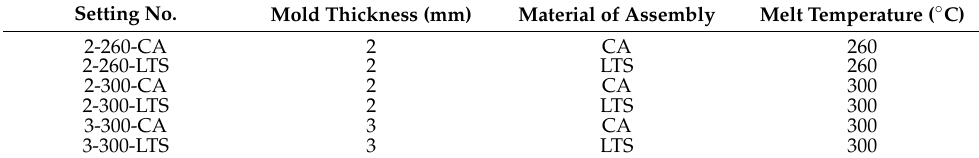
Table 2. The molding plane of the foils produced in [9] was extended by setting 2-260-CA and 2-260-LTS (mold temperature: 100 ◦ C, injection speed: 70 cm 3 /s, n = 3). Setting